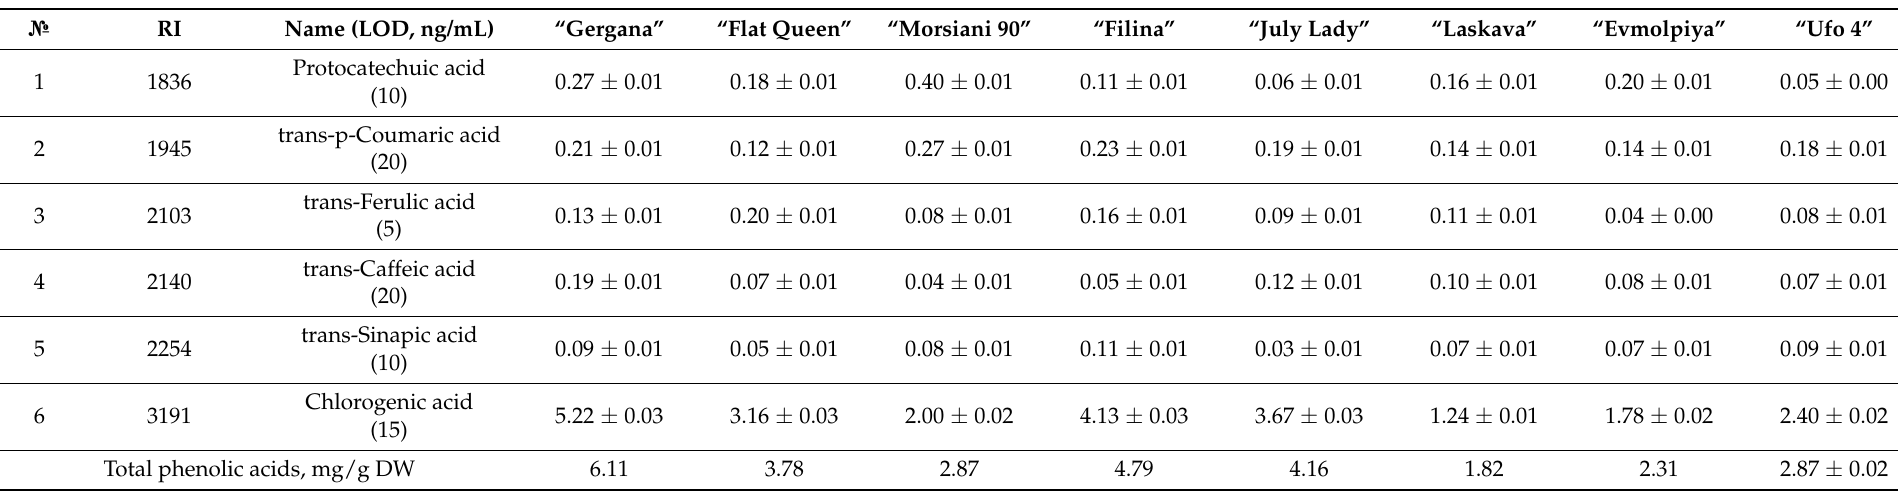
Table 2. Metabolites identified (mg/g DW) in polar fraction II of the peach ( Prunus persica L.)